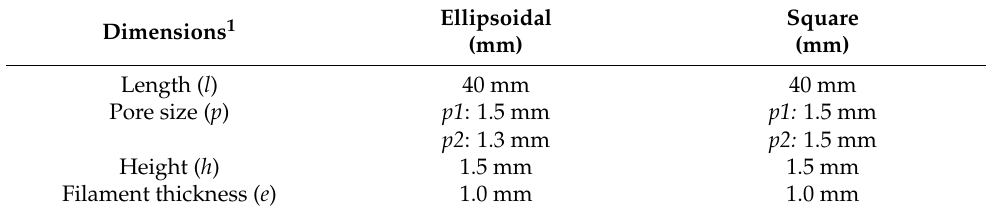
Figure 1. Scaffolds obtained by CAD. Values related with scaffold dimensions are listed in Table 1. Table 1. CAD scaffolds